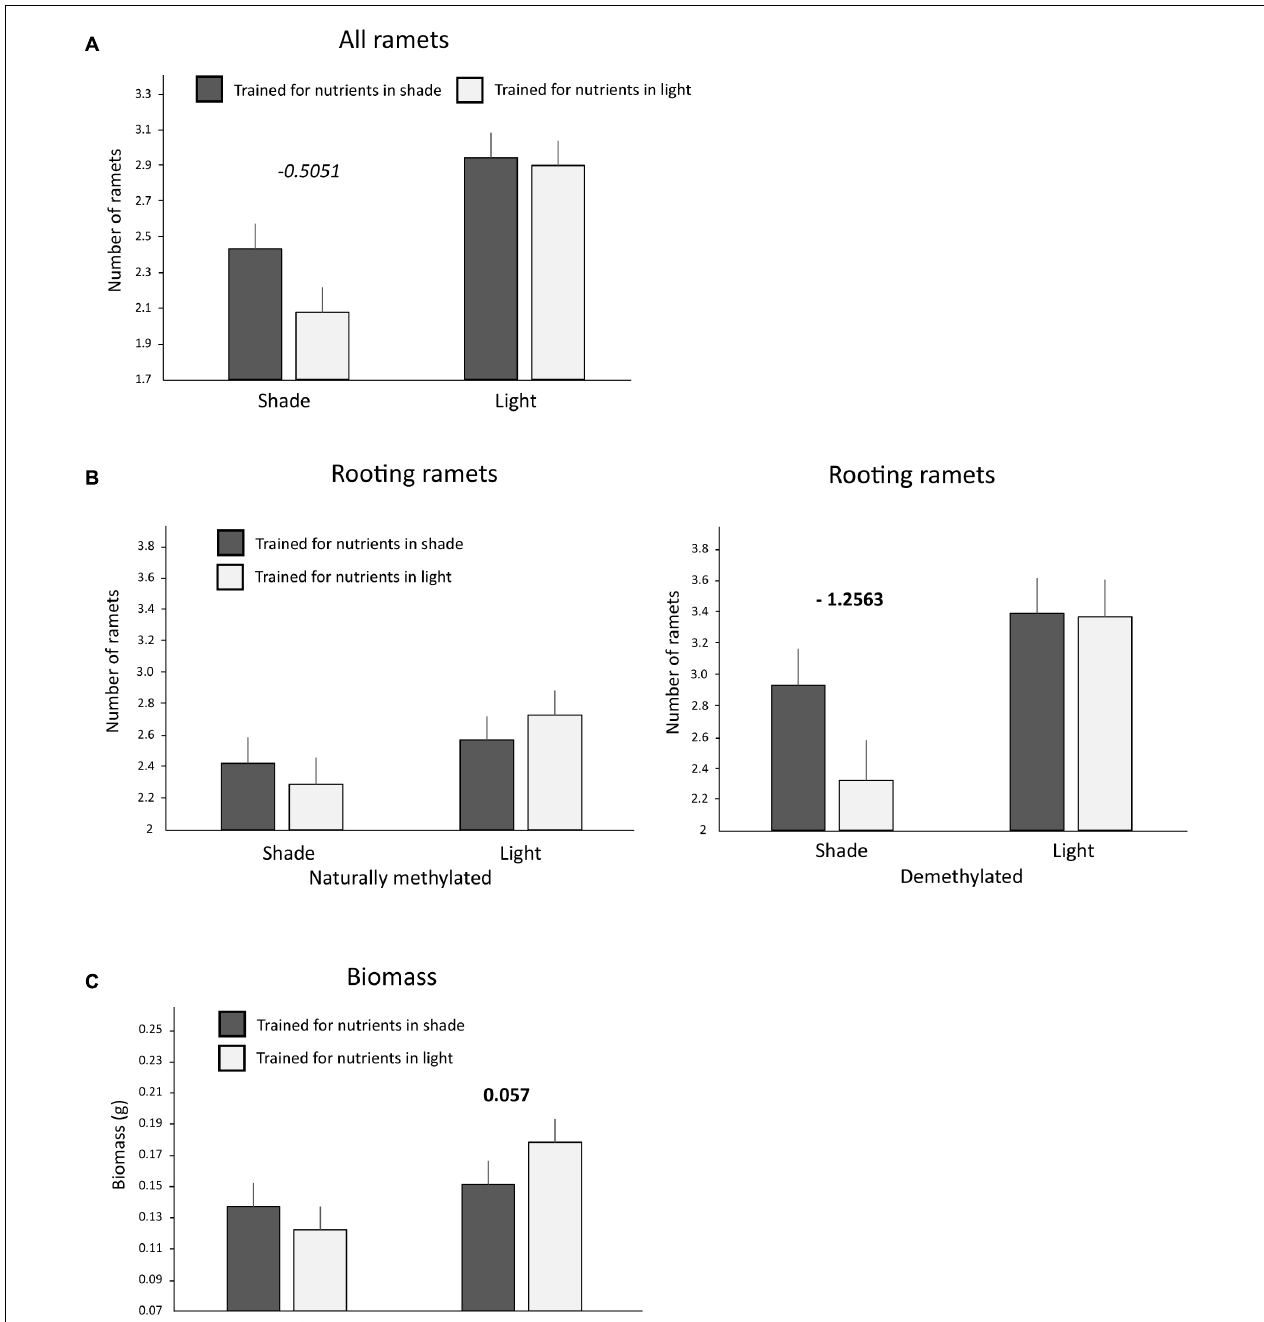
FIGURE 3 | Ramet and biomass production in the testing zone of nutrient heterogeneous plots. Presented are only significant interactions between training history and actual light intensity. (A) Number of all ramets of clones trained for nutrients to occur in shade or light. (B) Number of rooting ramets of clones trained for nutrients to occur in shade or light of naturally methylated and demethylated clones. (C) Biomass production of clones trained for nutrients to occur in shade or light. Significant interaction between training history (trained for shade/light) and actual light conditions (shade/light) represents significant difference in response to actual light intensity depending on previous training history, i.e., evidence of anticipatory behavior. Means and SE are shown. Above each pair of columns, we show the values of significant ( p < 0.05) in bold or marginally significant ( p < 0.1) in italics pair wise marginal effects estimated after accounting for all the other variables entering the corresponding models, see also Section “Materials and Methods.” No value above a pair of columns means no significant marginal effect.